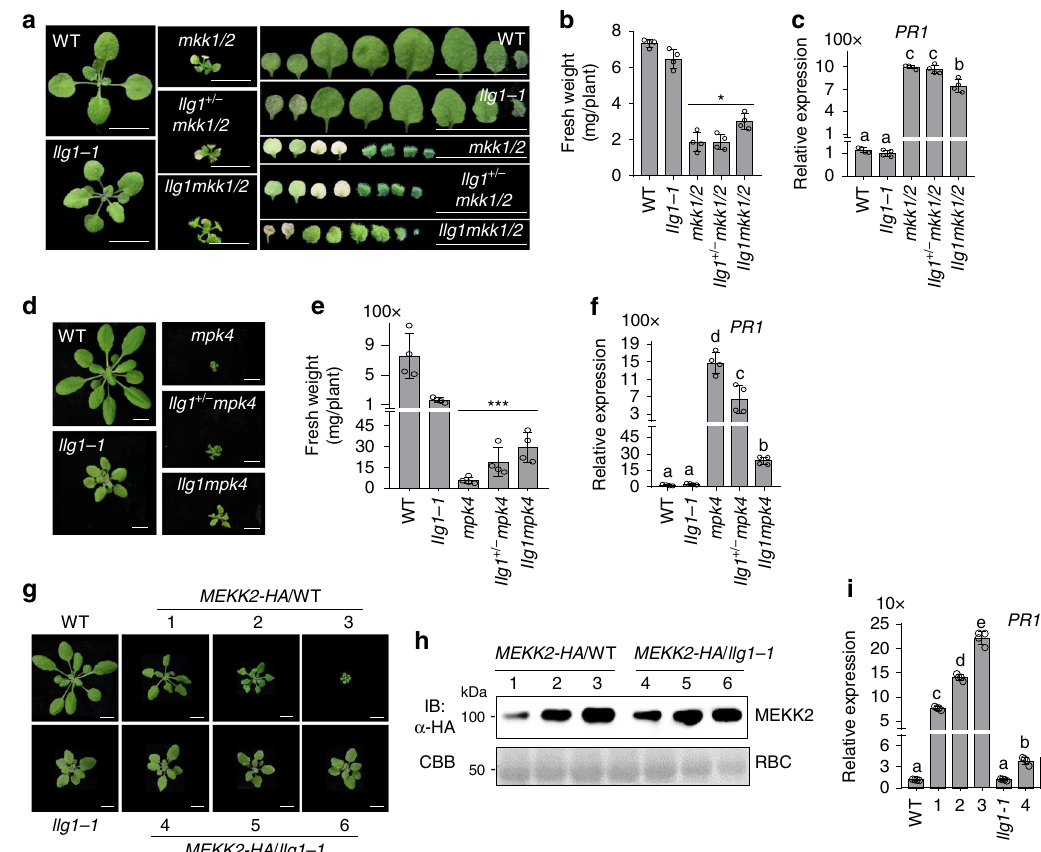
Fig. 6 LLG1 genetically functions downstream of MEKK2. a The llg1-1 mutant partially suppresses the mkk1/2 cell death. The seedlings grown on ½MS plate were photographed at 2-weeks post-germination. The leaves from the individual plants were placed with the order of age (from oldest to youngest, right panels). Scale bar, 0.5 cm. b llg1-1 increases the fresh weight of mkk1/2 . The data are shown as mean ± SE ( n = 4). P = 1.46 × 10 − 2 (column 3 and 5). The asterisk indicates statistical signi fi cance by using two-sided two-tailed Student ’ s t test (* P < 0.05). c The llg1-1 mutant reduces the expression of PR1 in mkk1/2 . The expression of PR1 was determined with the plants in a and normalized to the expression of UBQ10 . The data are shown as the mean ± SE of four biological repeats ( n = 4). P = 2.06 × 10 − 5 (column 3 and 5). The different letters indicate the signi fi cant difference determined by one-way ANOVA followed by the Tukey test ( P < 0.05). d The llg1-1 mutant partially suppresses the mpk4 cell death. The plants grown on soil were photographed at 4-weeks after germination. Scale bar, 1 cm. e llg1-1 increases the fresh weight of mpk4 . The data are shown as mean ± SE ( n = 4). P = 4.69× 10 − 3 (column 3 and 5). The asterisk indicates statistical signi fi cance by using two-sided two-tailed Student ’ s t test (*** P < 0.01). f The llg1-1 mutant reduces the expression of PR1 in mpk4 . The expression of PR1 was determined with the plants in d and normalized to the expression of UBQ10 . The data are shown as the mean ± SE of four biological repeats ( n = 4). P = 6.78 × 10 − 8 (column 3 and 5). The different letters indicate the signi fi cant difference determined by one-way ANOVA followed by the Tukey test ( P < 0.05). g Overexpressing MEKK2 triggers growth defects in WT, but not in llg1-1 . Three representative lines were used to indicate the phenotype of transgenic lines in WT Col-0 and llg1-1 with different MEKK2-HA expression level. The pictures were taken with 4-week-old soil- grown plants. Scale bar, 1 cm. h The protein accumulation of MEKK2-HA in WT and llg1-1 transgenic plants. Total proteins were isolated from plants in g and immunoblotted using an α -HA antibody (top panel). CBB staining of RBC is shown as the loading control (bottom panel). i The elevated expression of PR1 triggered by overexpressing MEKK2 in WT (Lines 1, 2, and 3) is reduced in llg1-1 (Lines 4, 5, and 6). The expression of PR1 was normalized to the expression of UBQ10 and the data are shown as the mean ± SE of four biological repeats ( n = 4). The different letters indicate the signi fi cant difference determined by one-way ANOVA followed by the Tukey test ( P < 0.05). To measure the weight of mkk1/2 and mpk4 mutants, 10 plants were pooled and the weight of individual plants was averaged. The above experiments were repeated three times with similar